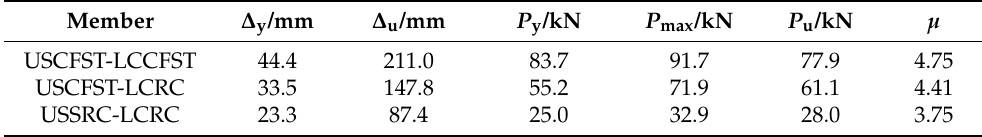
Table 10. Load-bearing performance and ductility index of the three types of components.